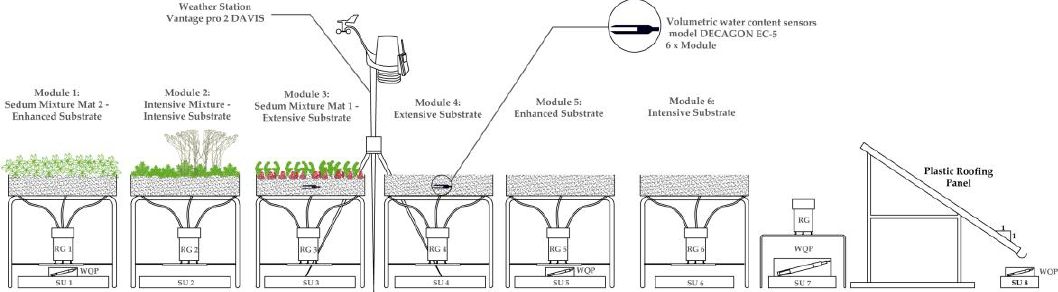
Figure 3. Experimental setup in the monitoring period from August 2015 to January 2017. RG: Rain gauge, WQP: water quality probe, SU: storage unit (used for measuring volume weighted concentrations).